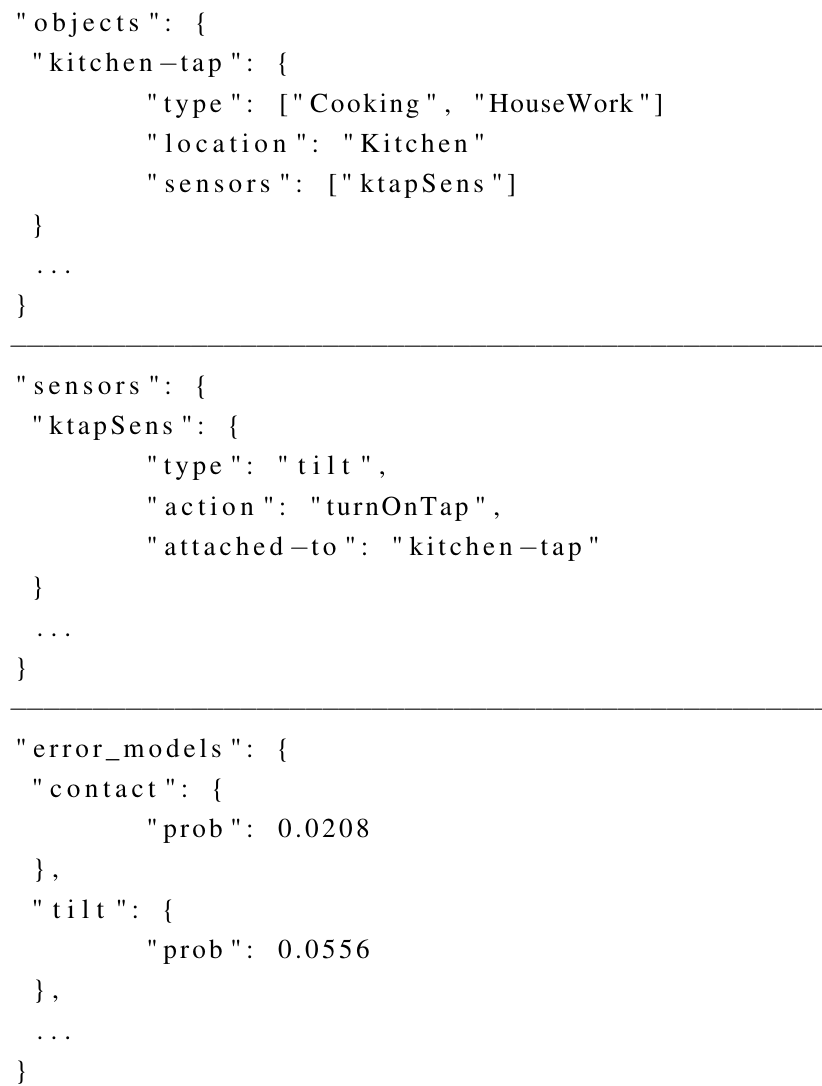
Figure 7. Example of information stored in the context knowledge file, divided into its three main concepts: objects, sensors and error